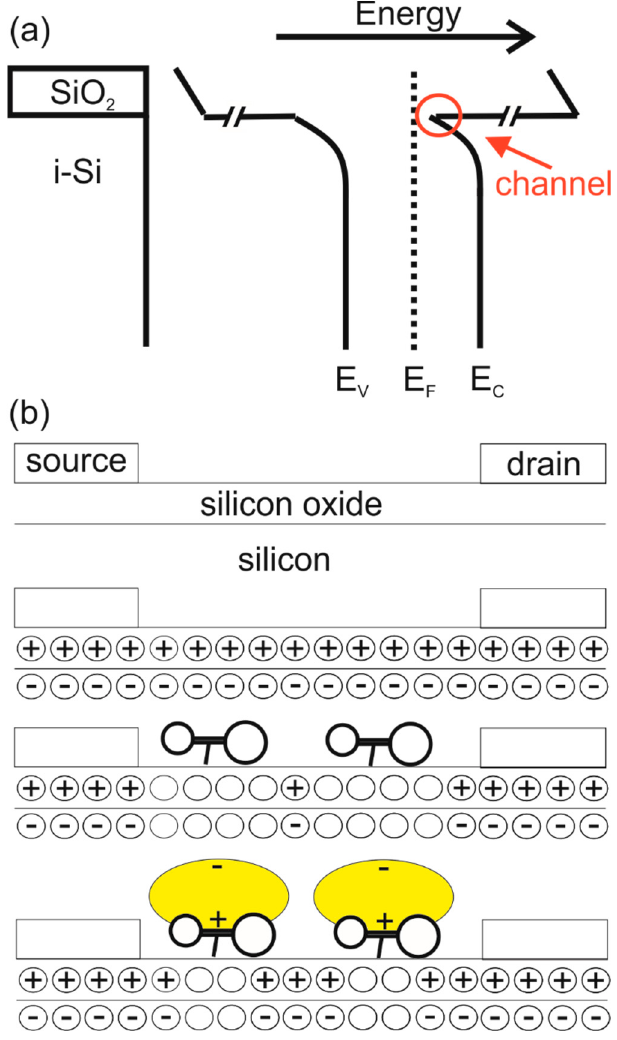
Figure 3. A schematic representation of the experiment. ( a ) shows the band diagram at the interface between the SiO 2 and the Si; the formation of the channel due to the band-bending is indicated. In ( b ) the effect of the presence of the aptamers and protein is indicated. At the top, the general layout of the FET is shown. The steps below illustrate the major points in the experiment. The ‘empty’ circles represent equal amounts of electrons and holes, whereas an area with a pre-dominantly negative or positive charge is indicated with a minus or plus signs, respectively.